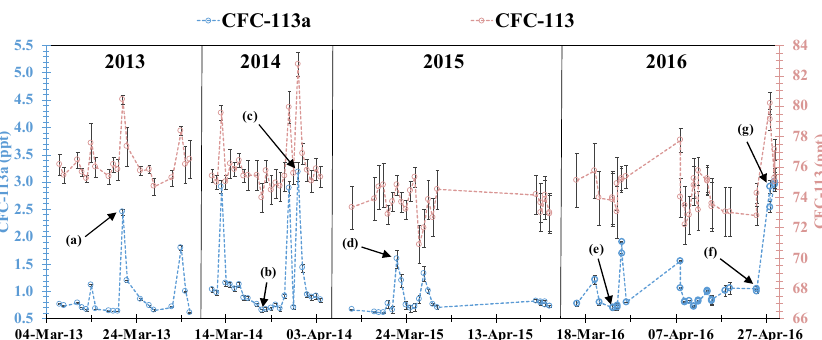
Figure 8. CFC-113a and CFC-113 mixing ratios observed in Taiwan in March and April 2013–2016. Arrows show the mixing ratios of CFC-113a that relate to the NAME footprints shown in Fig. 7. The error bars represent the 1 σ standard deviation.